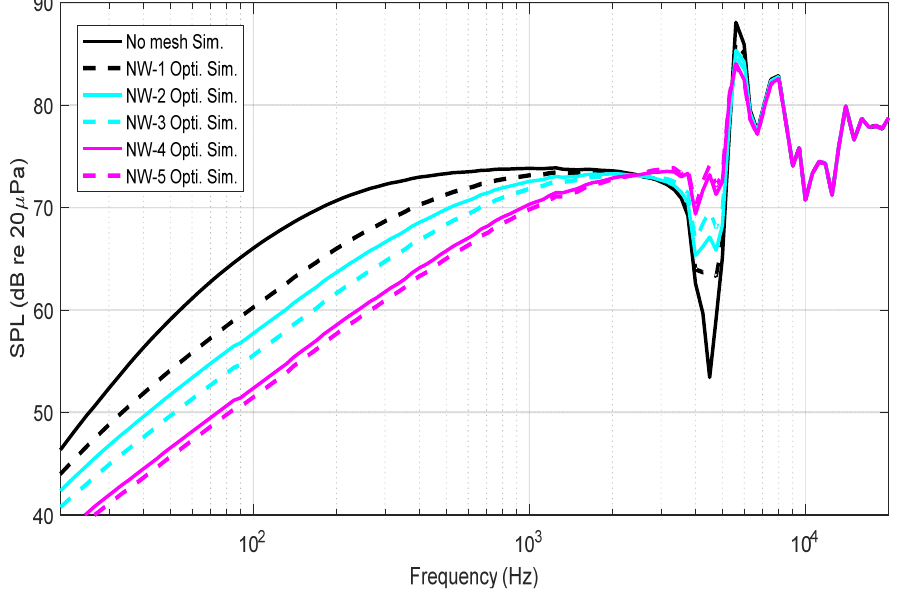
Figure 7. Simulated frequency responses of microspeaker without and with non-woven ventilation cloths (NW-1 to NW-5).